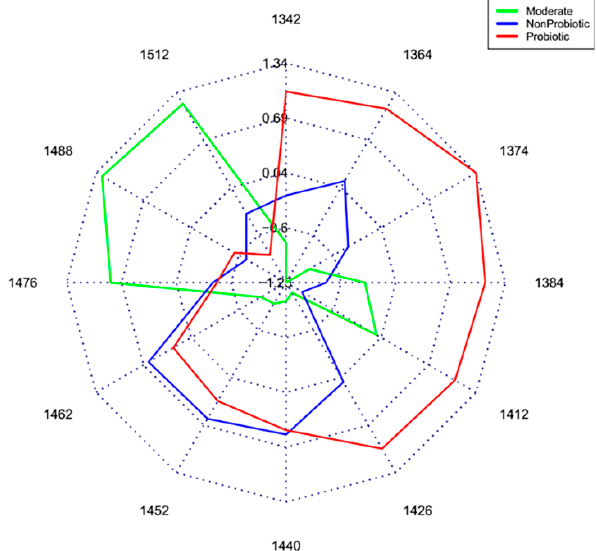
Figure 10. Aquagrams of culture media of groups of probiotic, moderate and non-probiotic strains. Average values of normalized absorbance values of the water matrix coordinates for each group are plotted on each wavelength axis [89].